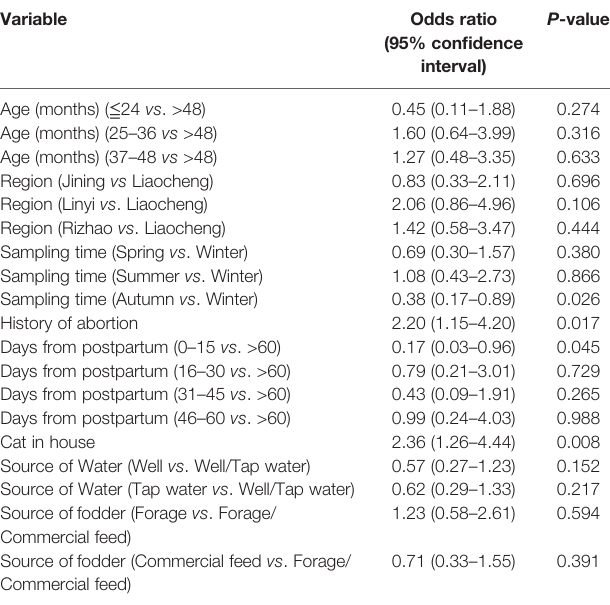
P -value (95% con fi dence interval)